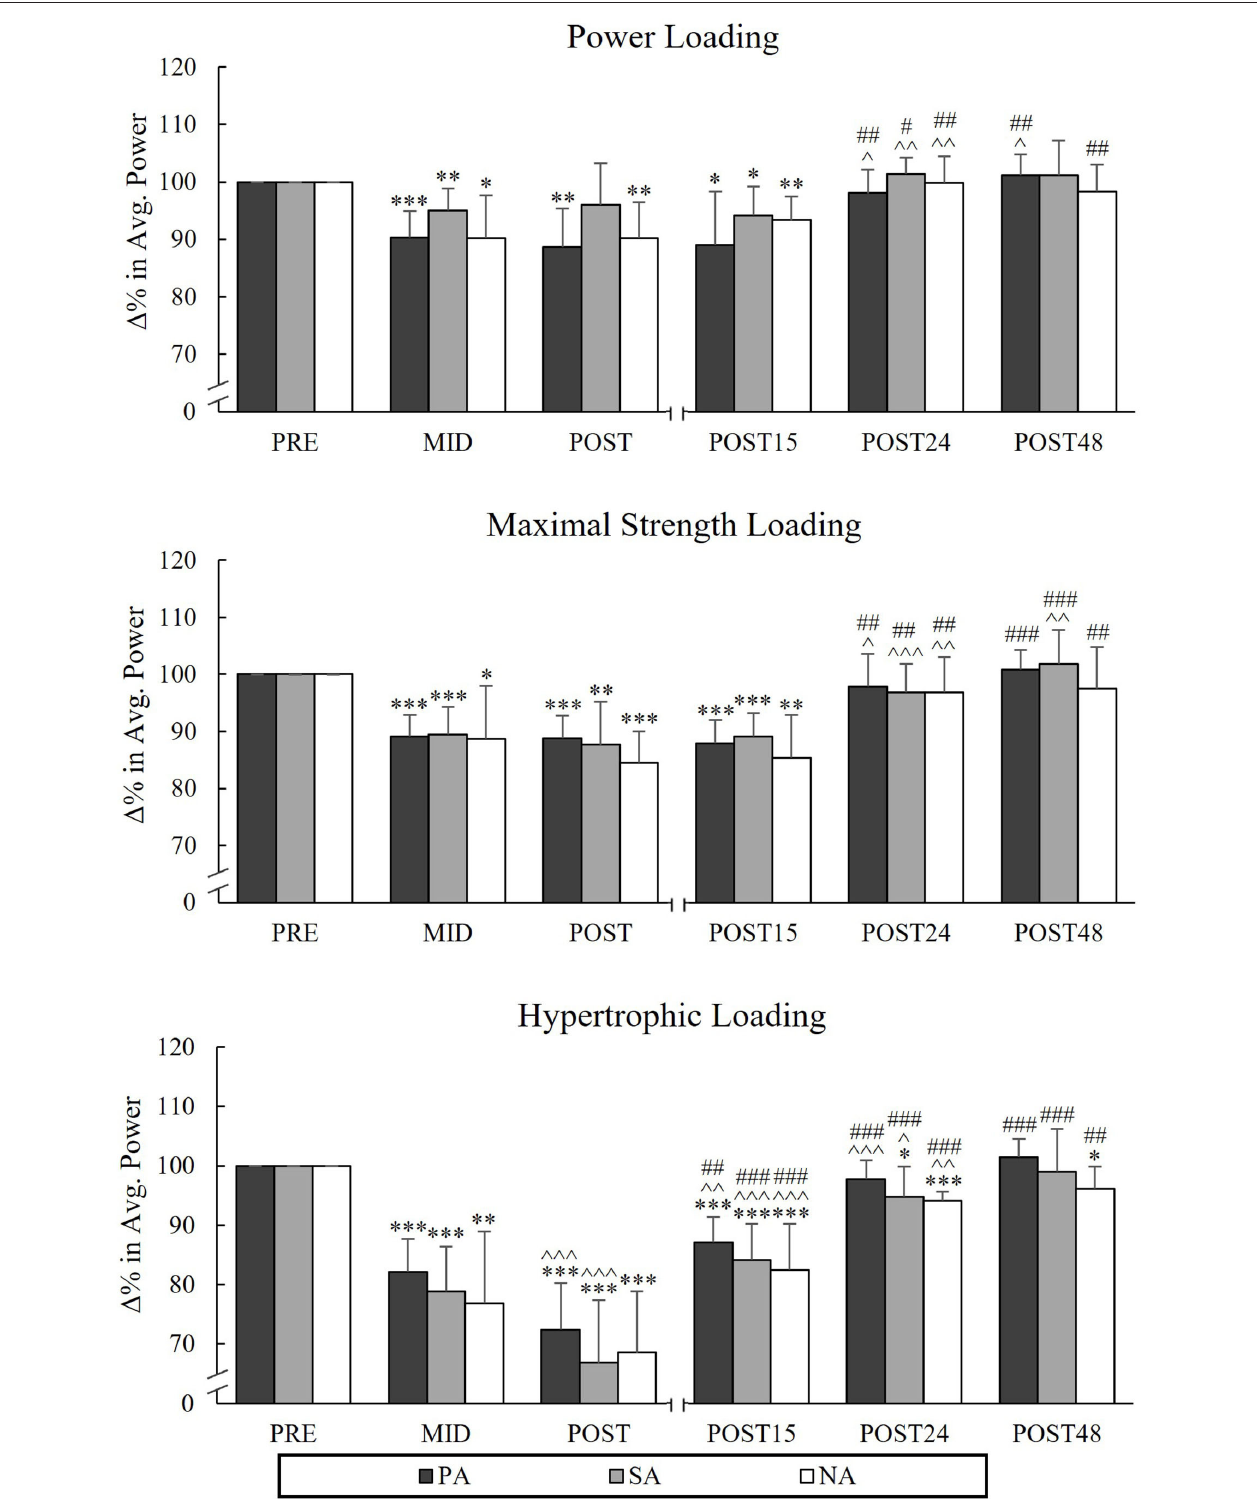
FIGURE 5 | Relative changes in average power during the concentric phase of maximal power back-squat in Smith machine during three resistance exercise loadings in power (PA), strength (SA), and non-athletes (NA). * p < 0.05, ** p < 0.01, *** p < 0.001 refer to within-group significances compared to Pre. ∧ p < 0.05, ∧∧ p < 0.01, ∧∧∧ p < 0.001 refer to within-group significances compared to the previous time point. # p < 0.05, ## p < 0.01, ### p < 0.001 refer to within-group significances compared to Post during recovery.